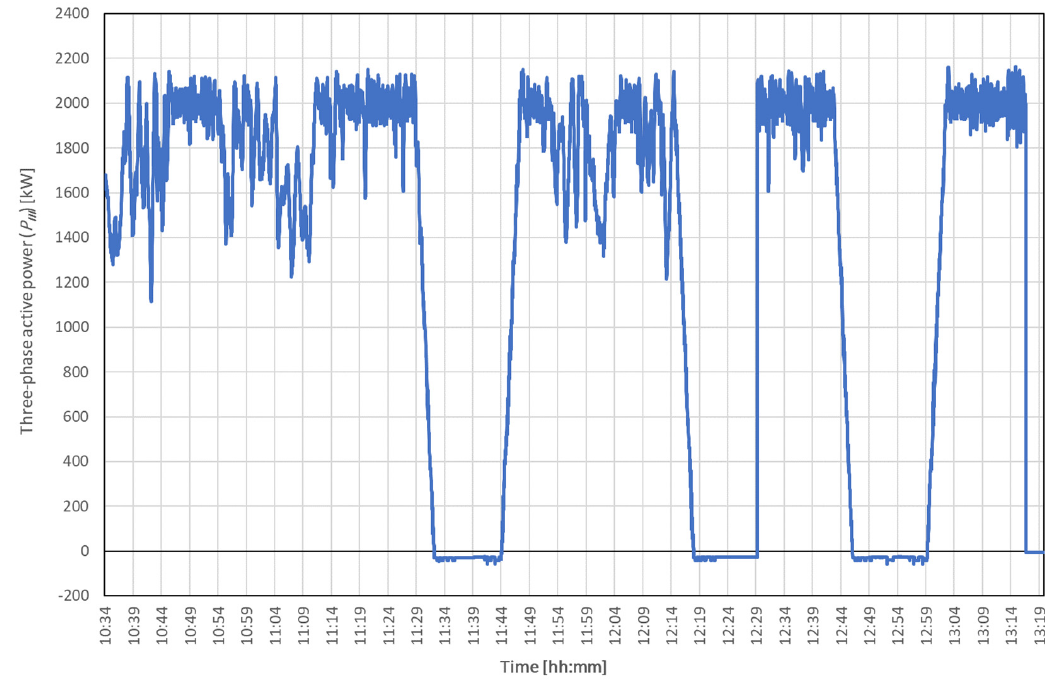
Figure 4. Time course of the value of three-phase active power ( P III ) generated by the wind power plant.